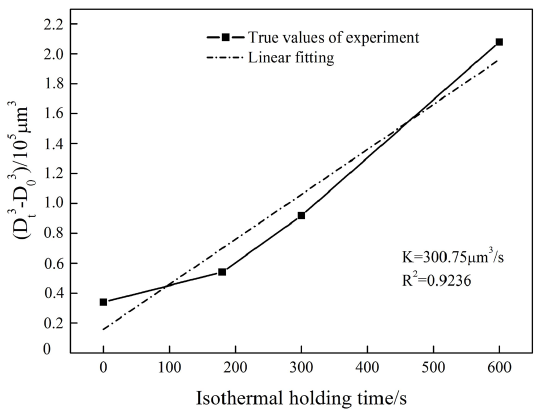
Figure 8. Linear fitting of primary particle size of ZA27